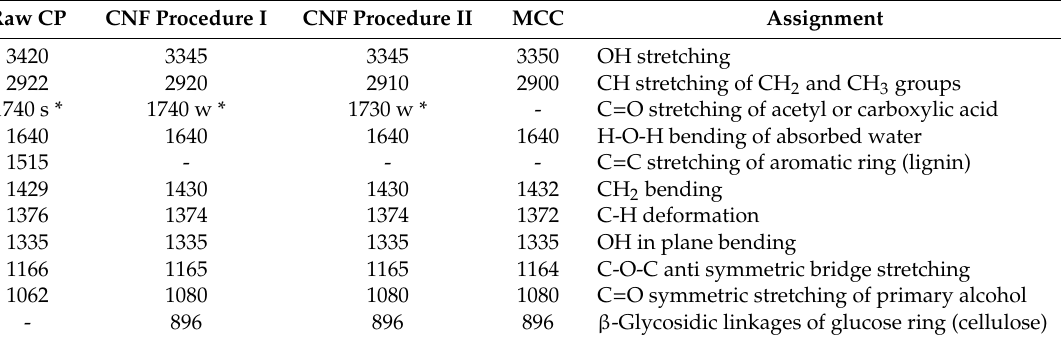
Table 2. Assignment of characteristic absorption peak (cm − 1 ) in cellulosic material [18].